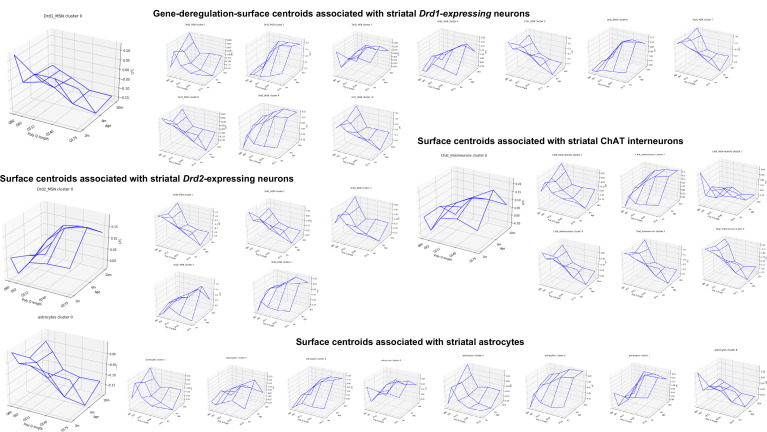
Centroids of the gene deregulation surface clusters associated with specific cell types in the striatum of Hdh model mice.This figure is related to step 2 in Figure 1.